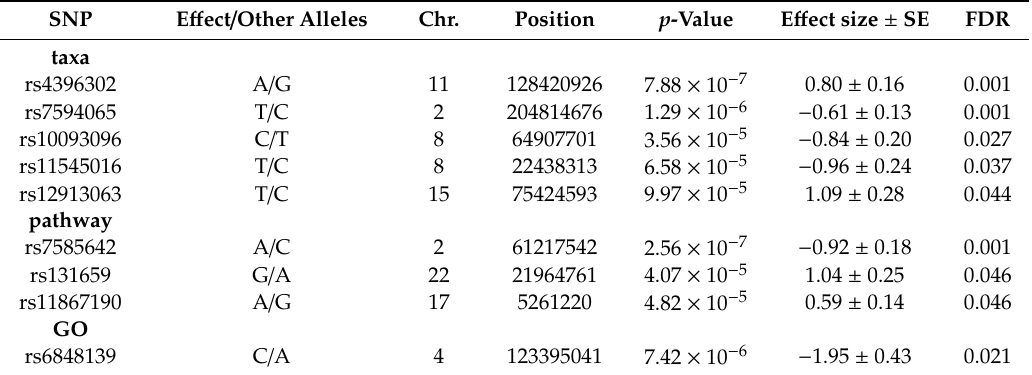
Table 1. Two-sample Mendelian randomization estimates between the gut microbiota and CeD. SNP E ff ect / Other Alleles Chr. Position p -Value E ff ect size ±